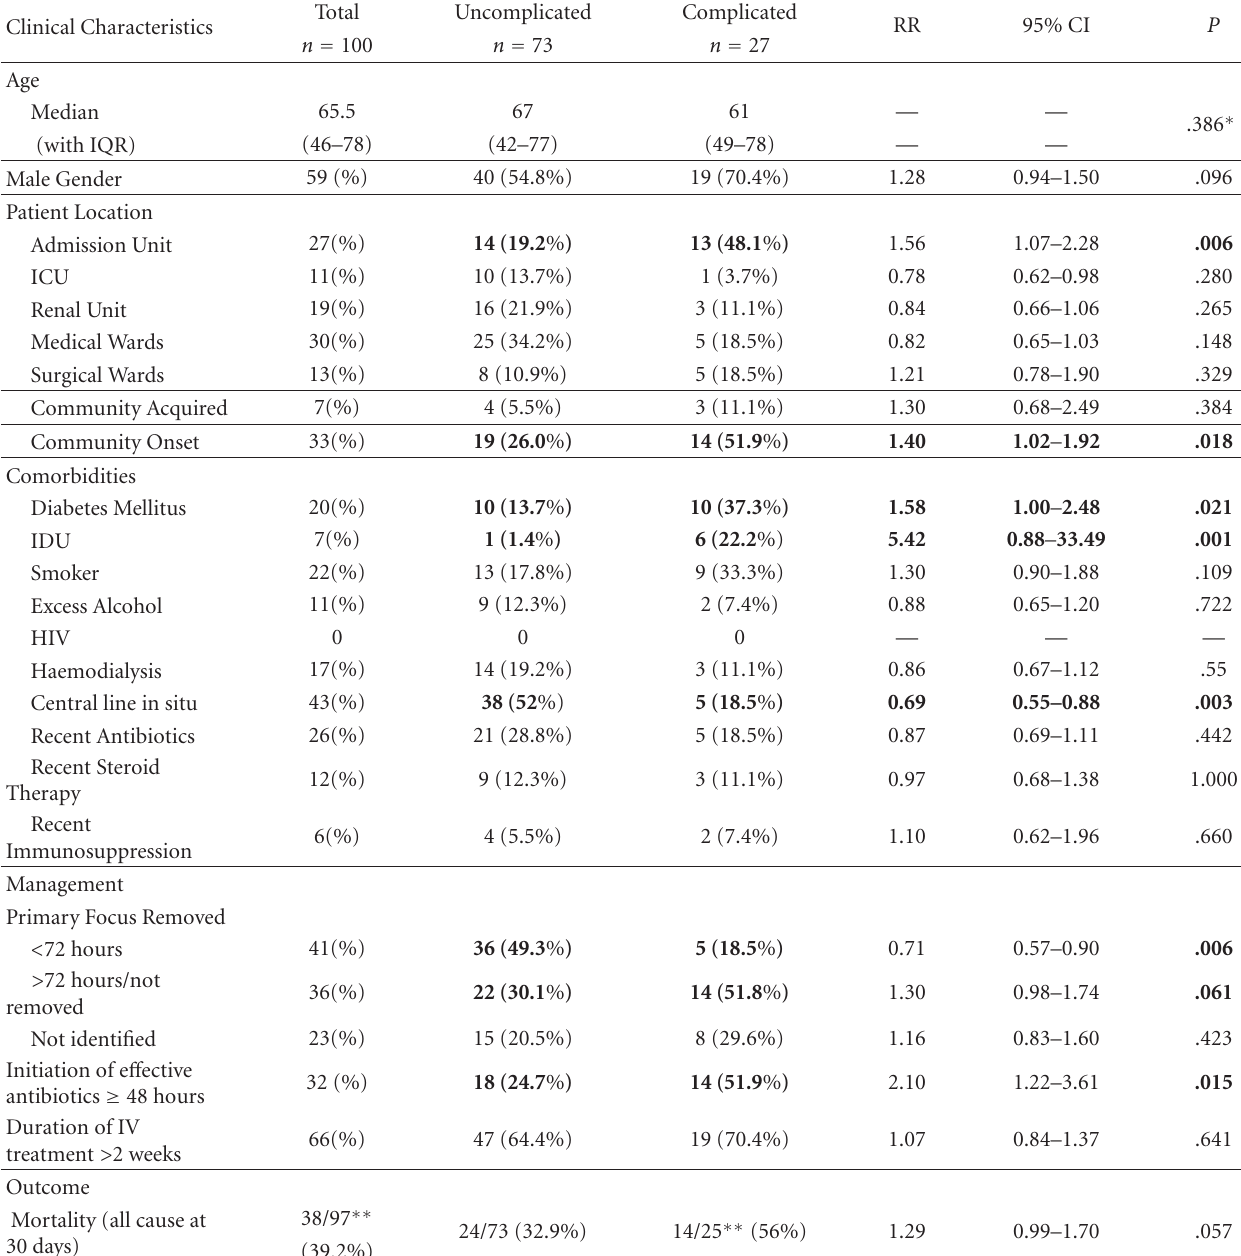
Table 1: Clinical Characteristics of 100 cases of S. aureus bacteraemia identified prospectively from 2006 to 2007. Clinical